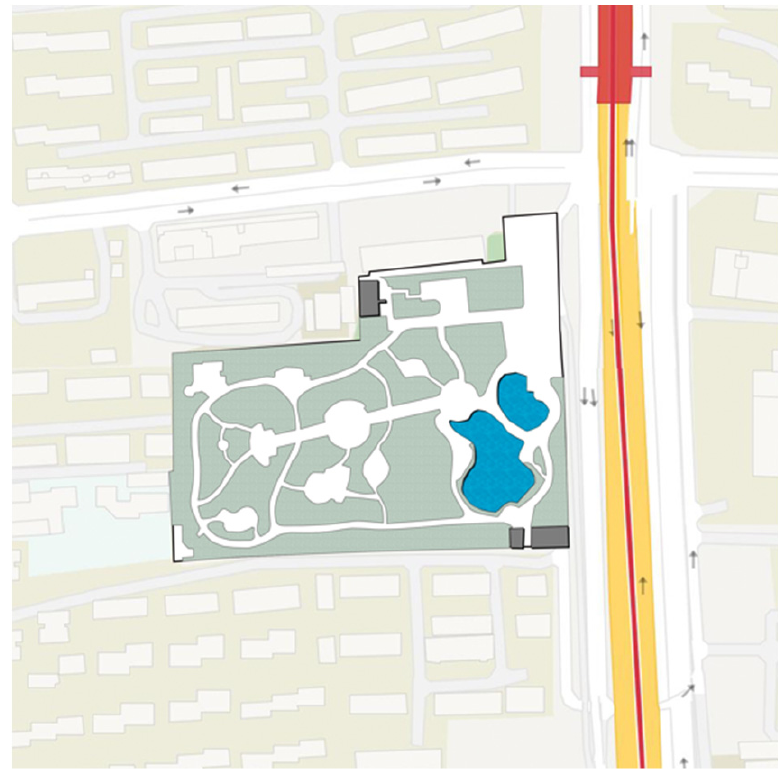
Figure 3. Map of Pengpu Park.